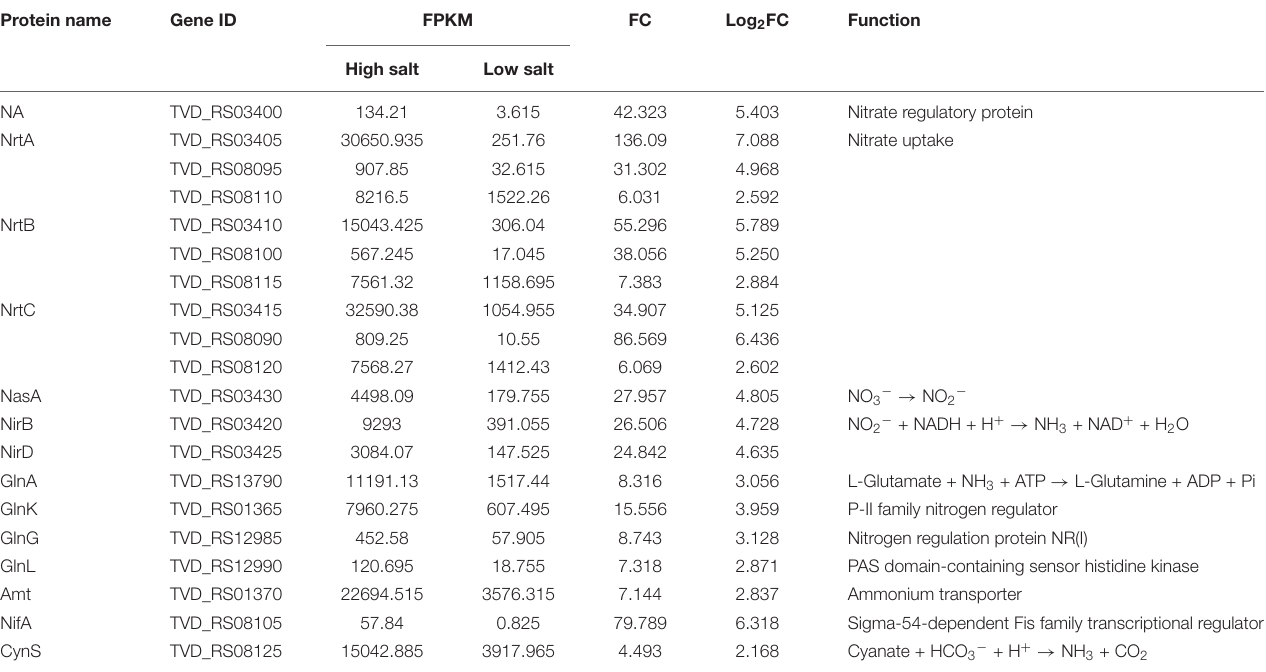
FIGURE 3 | Transcriptomic analysis of differentially expressed genes (DEGs) between high-salt and low-salt conditions. (A) Volcano plot of the DEGs. Red dots indicate significantly upregulated genes, while green squares indicate significantly downregulated genes. The |log2FC| > 2 and an adjusted P < 0.05 was used as threshold values. (B) The top twenty GO enrichment terms from DEGs. TABLE 2 | The significantly upregulated genes related to nitrogen metabolism #